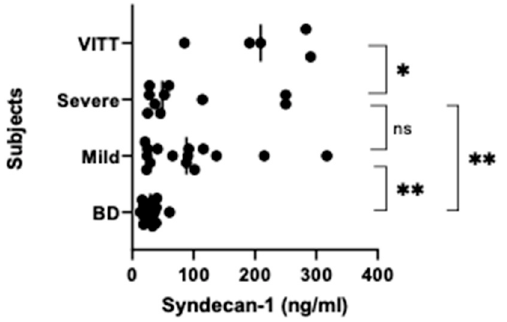
Figure 4. Syndecan-1 levels. Syndecan-1 levels were examined in the same samples as in Figure 2 by use of a commercial ELISA kit. p < 0.0001 for one way ANOVA, and for pairwise comparisons: * p = 0.023 and ** p < 0.005. ns (not